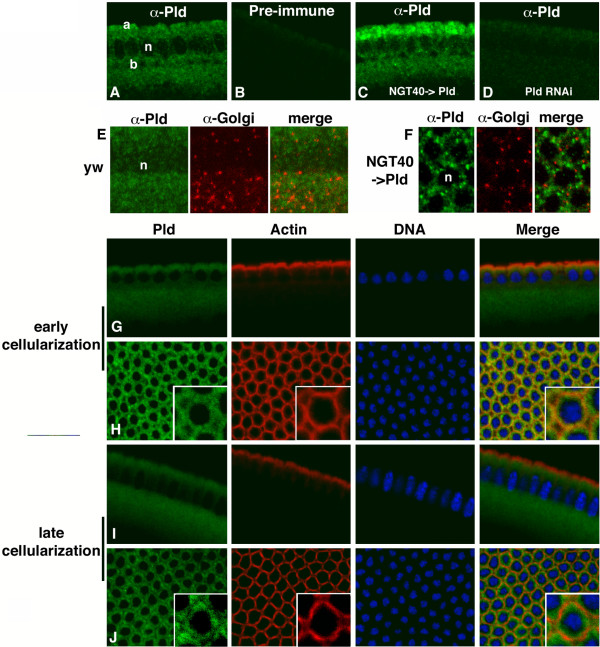
Pld localizes to cytoplasmic vesicles during cellularization. A. Pld localization in heat-fixed y1w67c23 control embryos using an affinity-purified anti-Pld antisera (sagittal image generated at or near the embryonic equator). a, apical; n, nuclei; b, basal. B. Affinity-purified pre-immune serum does not generate a visible signal. C. Pld localization in transgenic lines overexpressing Pld as a maternal transcript using NGT-GAL4. D. Pld localization in transgenic lines expressing Pld RNAi. E, F. Pld does not co-localize with p120-marked Golgi vesicles (red) in wild-type (sagittal section) or Pld; NGT40+A embryos (surface view). G-J. Cellularizing embryos immunostained with anti-Pld antisera (green), monoclonal anti-actin (red), and Propidium iodide (blue). Pld in early cellularizing embryos (G, H) co-localizes with actin at sites where adjacent cells are forming junctions (inset). Later in cellularization (I-J), Pld does not localize to sites at which actin tracks have been assembled (inset).